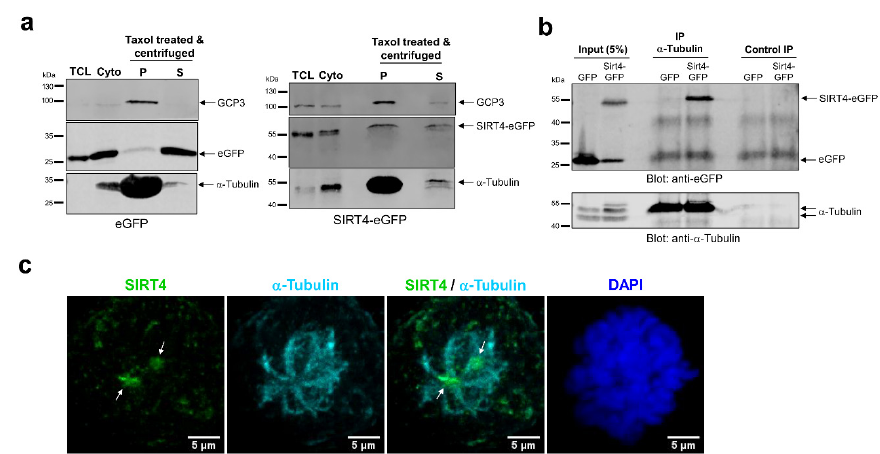
Figure 6. SIRT4 precipitates with microtubules and co-immunoprecipitates with α -tubulin in HEK293 cells. ( a ) SIRT4-eGFP, but not eGFP, is present in the pelleted fraction (P) of microtubules which were Taxol-stabilized in the cytosolic fraction (Cyto) followed by pelleting via centrifugation through a sucrose cushion. TCL, Total cell lysate; S, supernatant. Tubulin Gamma Complex Associated Protein 3 (TUBGCP3 or GCP3) was detected as co-marker for microtubules ( b ). An α -tubulin specific antibody co-immunoprecipitates SIRT4-eGFP, but not eGFP, from total cell lysates of stably transfected HEK293 cells. As control, immunoprecipitation without α -tubulin antibody was performed. ( c ) Localization of SIRT4 at spindle poles/Microtubule Organizing Centers (MTOCs) of mitotic HeLa cells using a polyclonal antibody against SIRT4 (sc-135053, Santa Cruz Biotechnology, Heidelberg, Germany) and analysis by spinning disk microscopy. Antibodies against α -Tubulin were employed to visualize microtubules. DAPI was used to detect DNA. Bar: 5 µm.